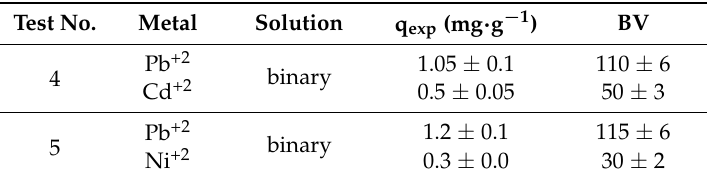
Figure 4. Breakthrough curves in distilled water of lead/cadmium and lead/nickel binary solutions (0.2 Lh -1 flow rate, 2 mg Me +2 L − 1 , 10g RWPG, 0.5-1 mm bead size range, pH = 6, and T = 298 K). Table 3. Sorption parameters of binary ion solutions of lead, cadmium and nickel ions (0.2 Lh − 1 flow